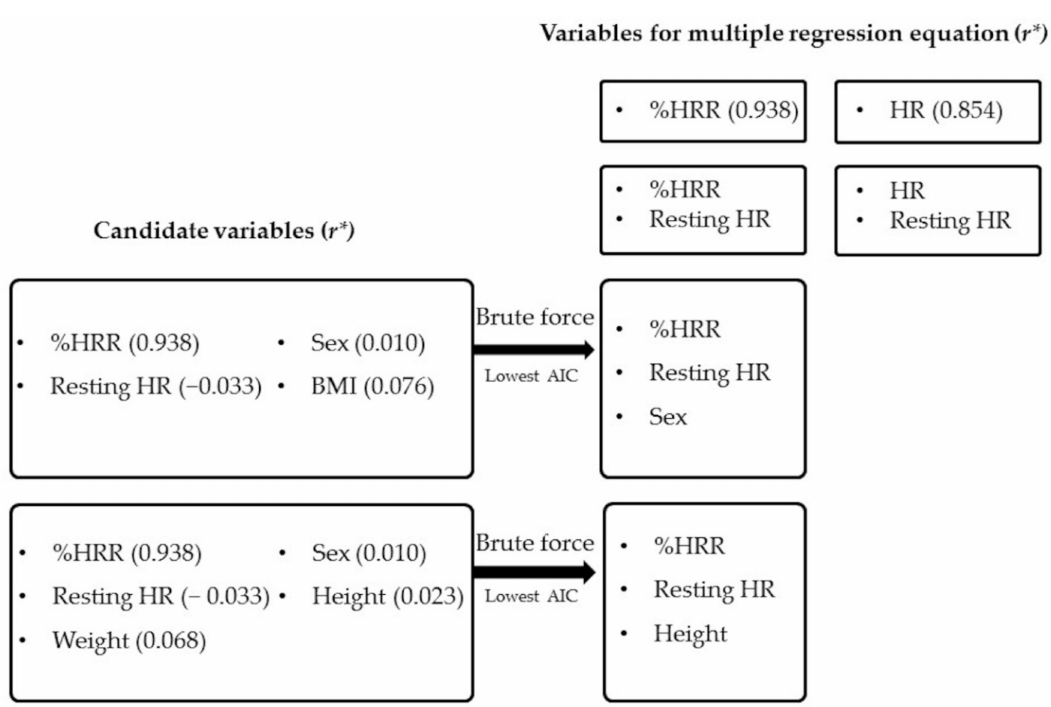
Figure 1. Selection of independent variables (n = 40). Dependent variable was METs. All possible combinations of variables were computed by using the brute force method. After that, the model with the minimum value of Akaike’s Information Criterion (AIC), which gives the best fit of all models, deleting redundant variables was selected. * r is the correlation coe ffi cient between METs and each